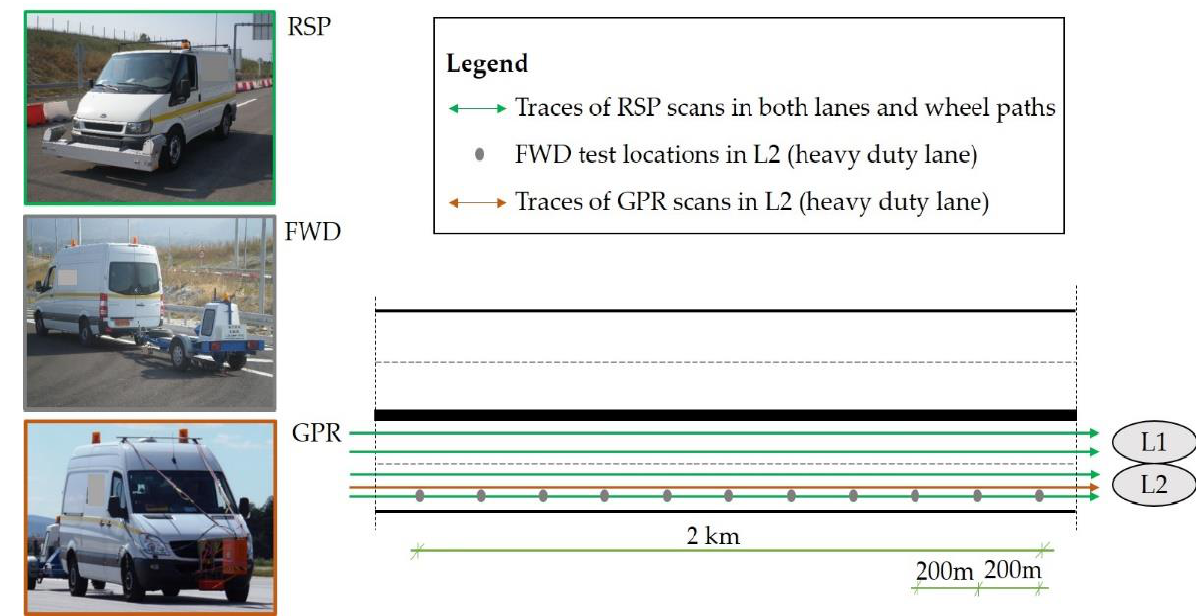
Figure 5. Experimental framework with multiple sensing systems including a Road Surface Profiler (RSP), a Falling Weight Deflectometer (FWD) and a Ground Penetrating Radar (GPR). Table 2. Monitoring periods.